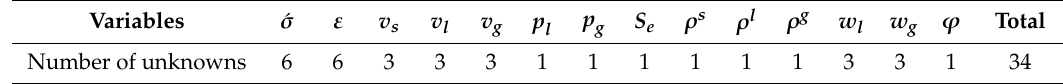
Table A2. List of unknown